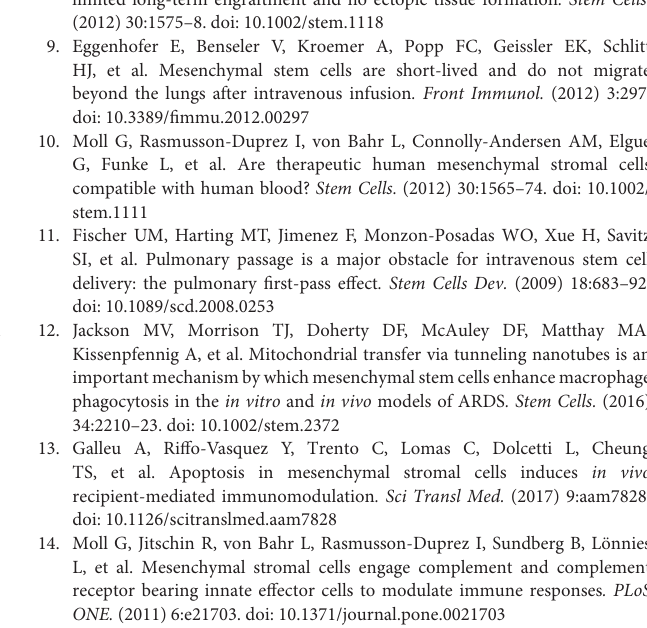
Figure S1 | Complement inhibitors CD46, CD55, or CD59 are not toxic on MSC. Representative contour plots of calcein RO stained MSC and exposed to plasma, HI plasma or medium for 1 h in the presence or absence of complement inhibitors CD46, CD55, or CD59. Data is representative of 5 MSC of two independent experiments. Figure S2 | Representative contour plots showing shape (FSS) and granulosity (SSC) of MSC after incubation for one hour with or without active plasma, in the presence or absence of complement inhibitor anti-CD59. Data are representative of at least three different experiments. Figure S3 | Phagocytosis of MSC is mediated by classical and intermediate monocytes. Presence of non classical monocytes among other subsets on gated pHrodo Low MSC. Pooled data of two different donors (PBMC =